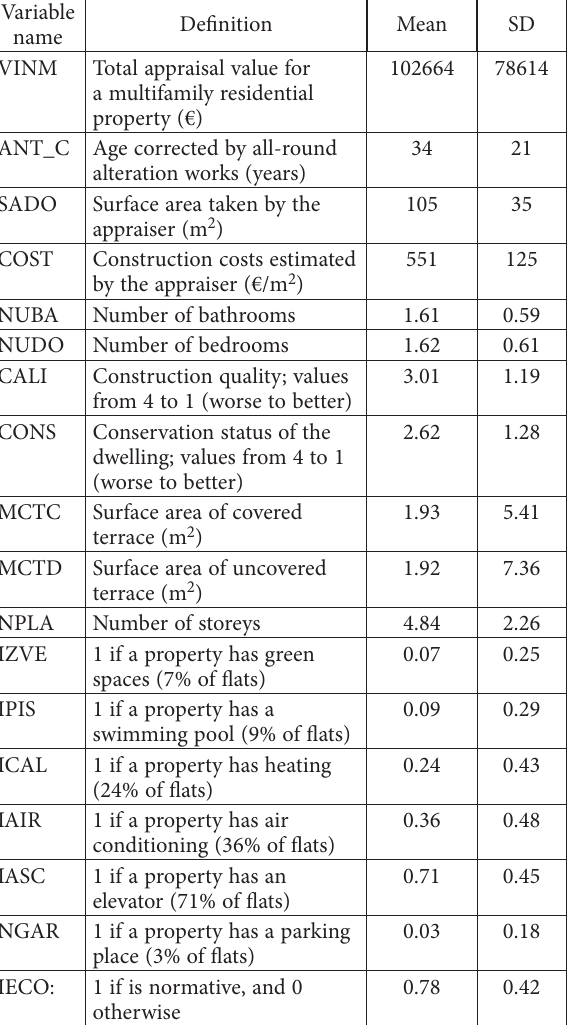
Table 1. Variable definitions, means and